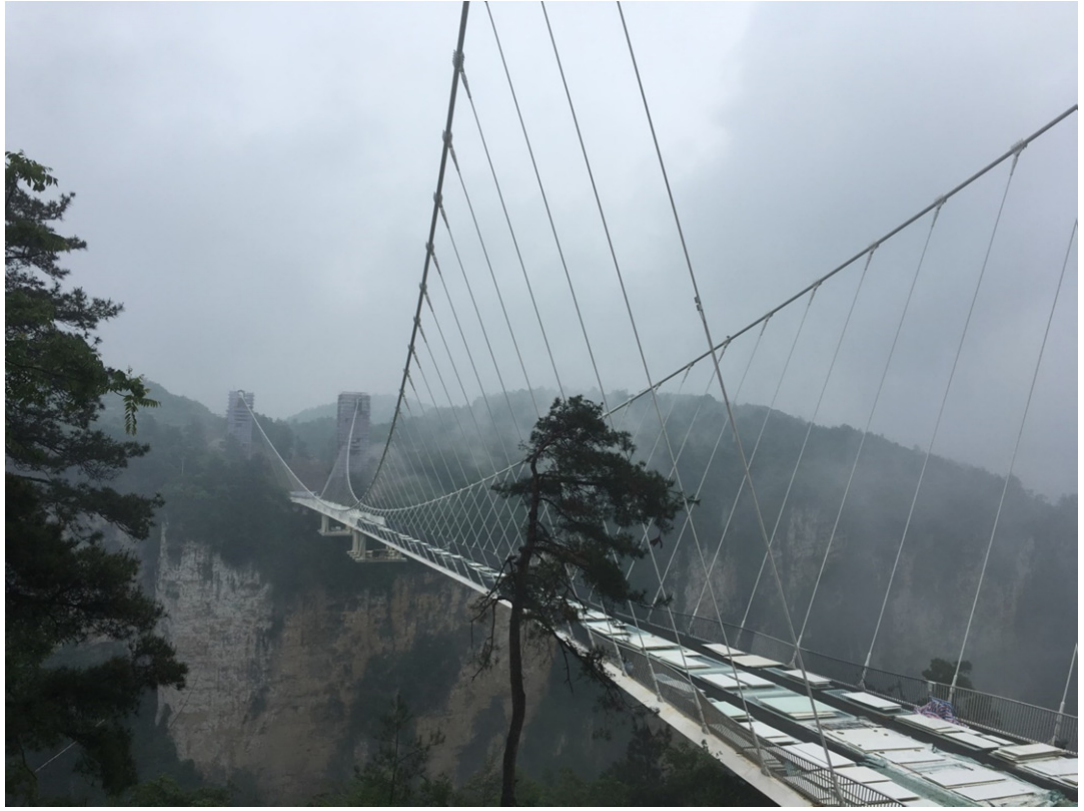
Fig. 7 Zhangjiajie bridge under construction, side view.